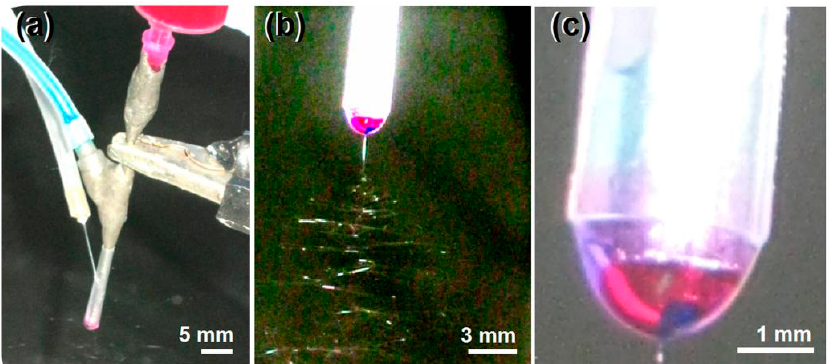
Figure 3. Observations about the modified triaxial electrospinning: ( a ) A digital picture of the connections of three working fluids and the high voltage with the spinneret; ( b ) a digital image showing a typical preparation process of the CSFs; ( c ) a typical compound tri-layer Taylor cone.